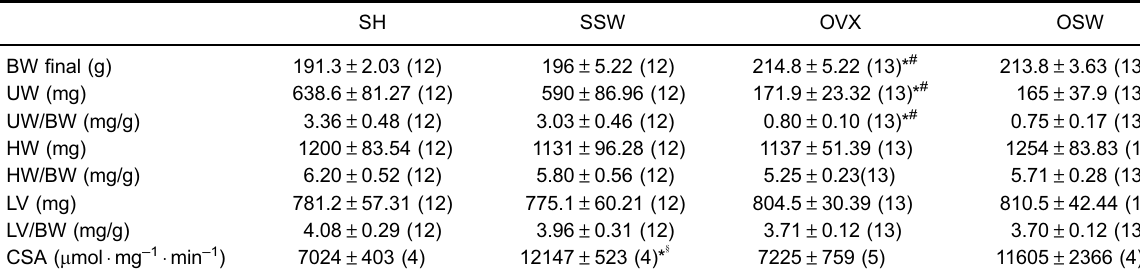
Table 1. Body weight, estrogen status, and cardiac weight.